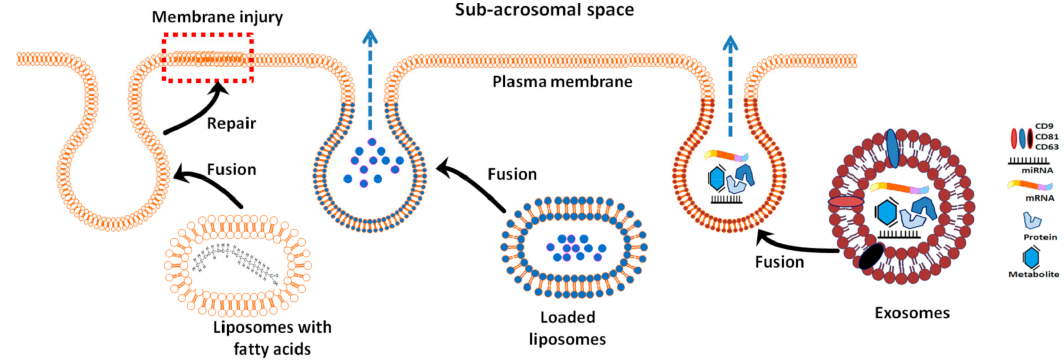
Figure 1. The proposed mechanism of spermatozoa protection through exosomes and liposomes. Liposomes with their contents of fatty acid can replenish the damaged sperm plasma membrane caused by freezing / thawing. Liposomes when artificially loaded with certain chemicals and exosomes with their contents of miRNA, mRNA, proteins, and metabolites can fuse and transfer their cargo into the subacrosomal space and inside the